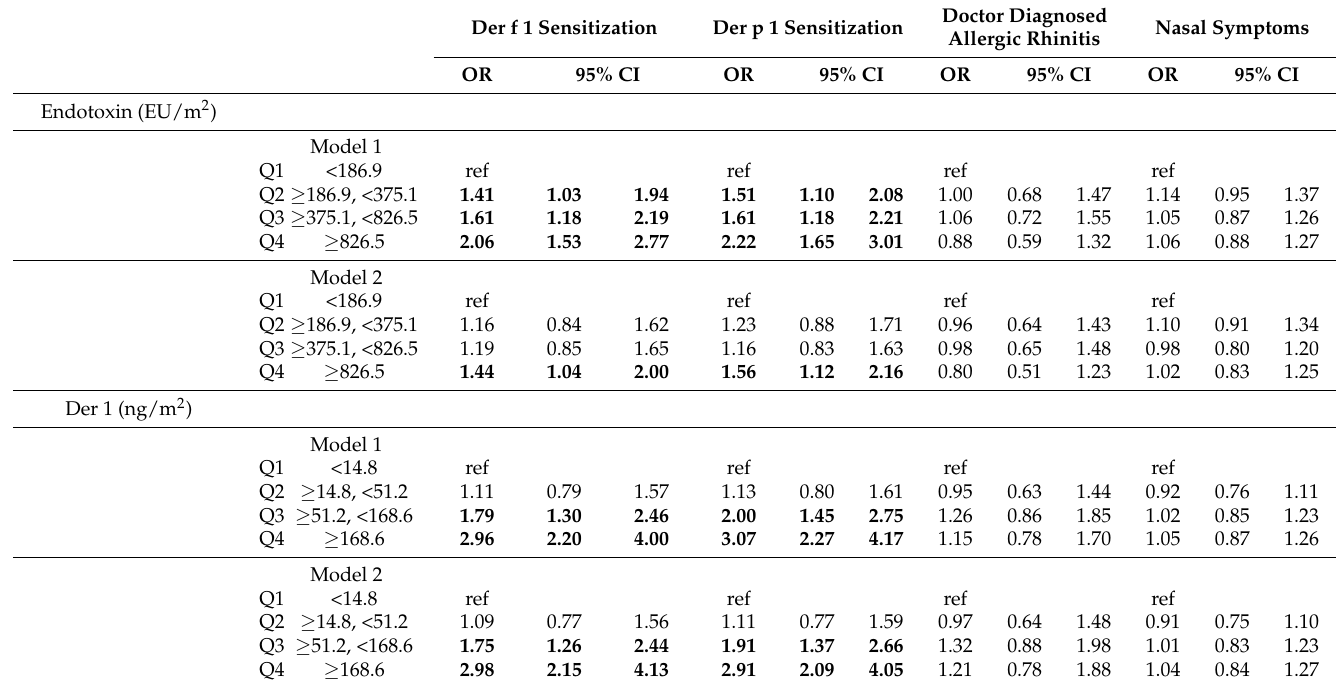
Table 3. Odds ratios of sensitization to Der 1 and allergic rhinitis in relation to endotoxin or Der 1 exposure in